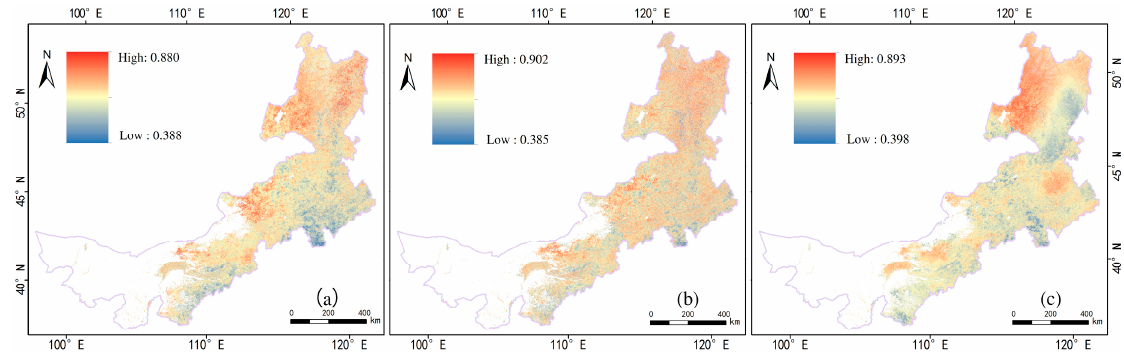
Figure 8. GRG between EVI and air temperature ( a ); relative humidity ( b ); and precipitation ( c ).